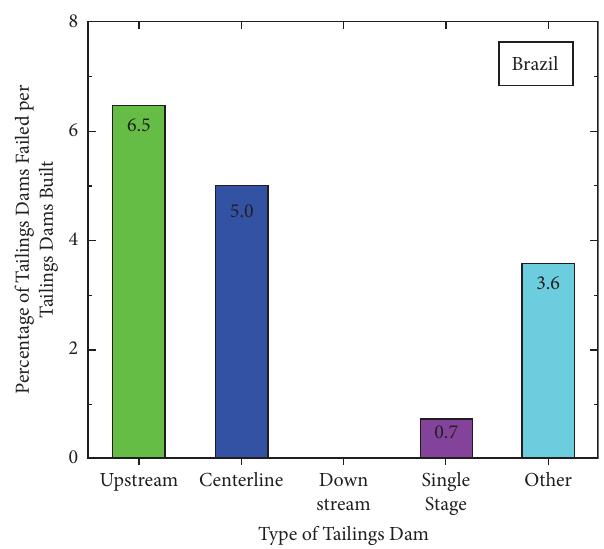
Figure 2: Percentage of tailings dams failed per tailings dams built in Brazil according to dam type (data from Bowker [22] and Agˆencia Nacional de Mineração